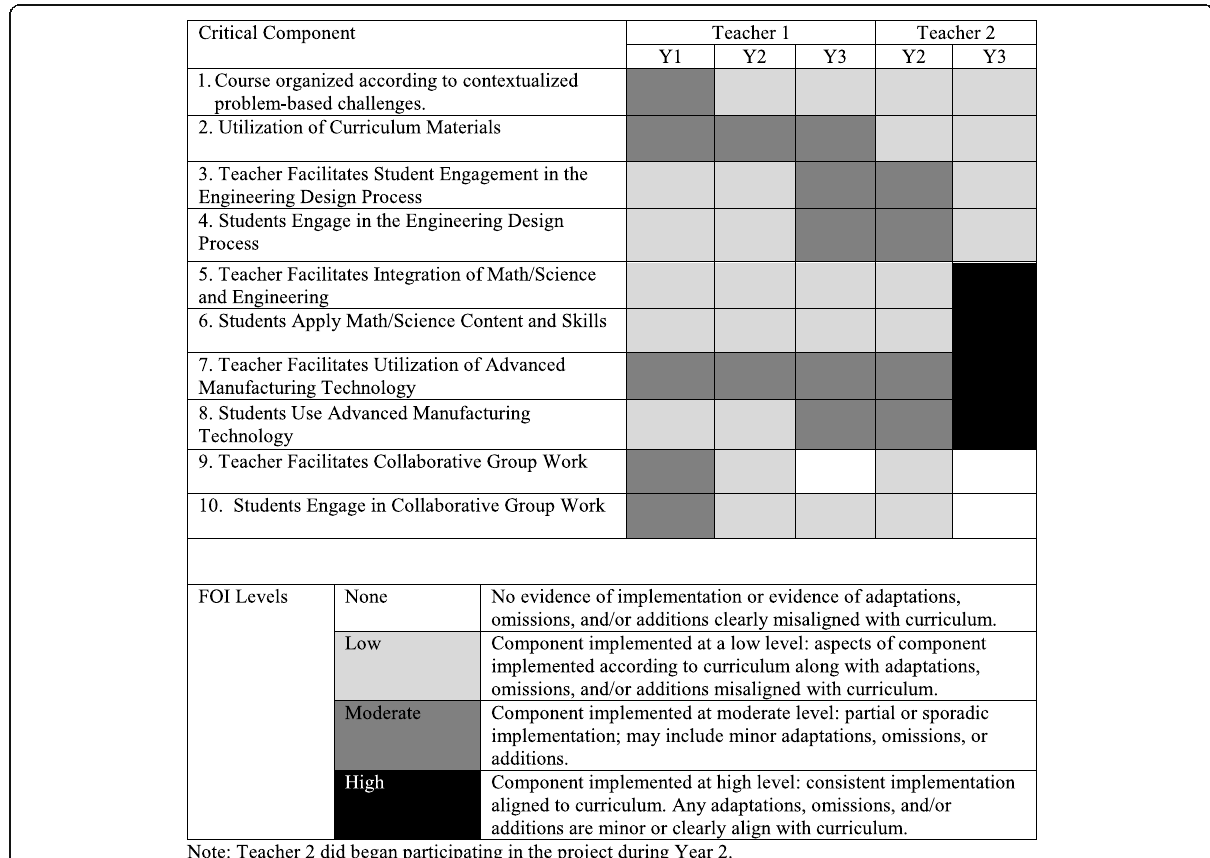
Fig. 1 Matrix illustrating levels of implementation for two teachers by